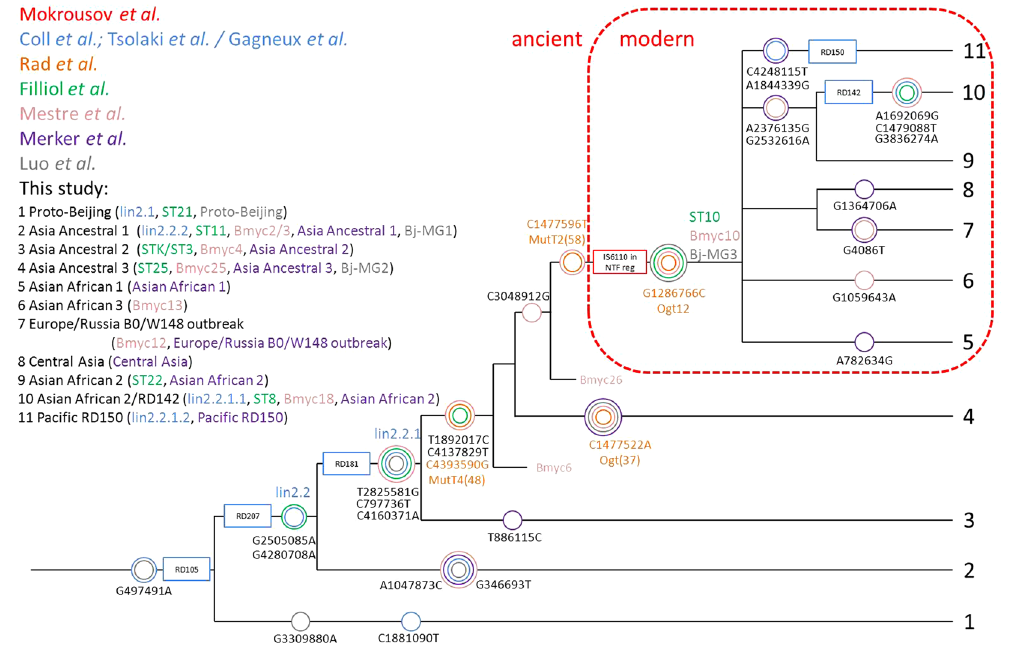
Figure 2. Mtb lineage 2 dendrogram representing the major phylogenetic groups and informative genetic